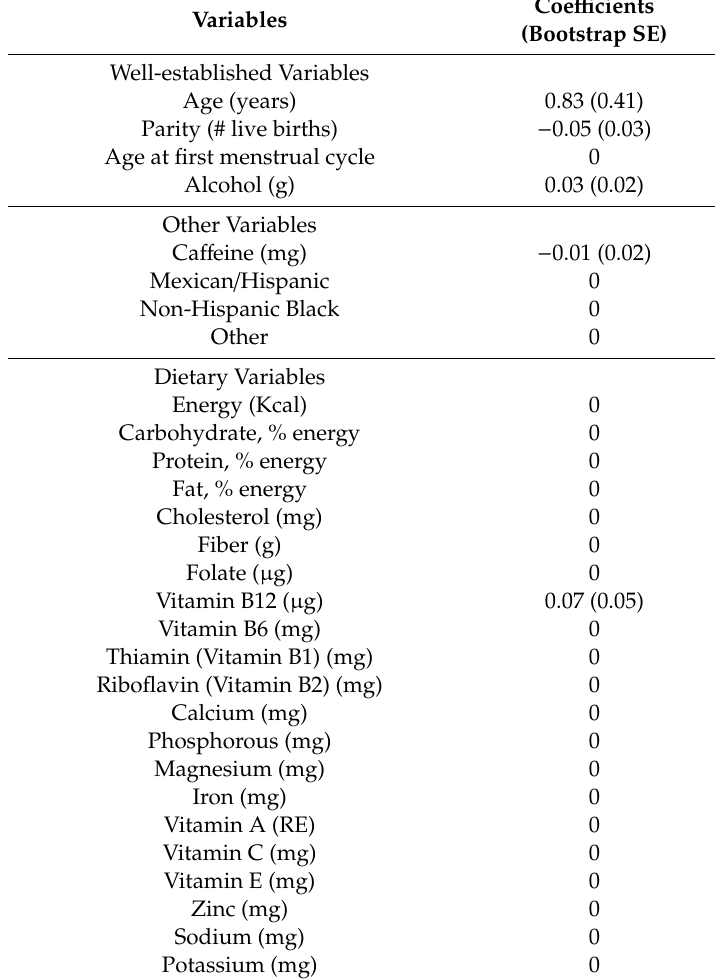
Table 3. The estimated coe ffi cients for logistic least absolute shrinkage and selection operator (LASSO) regression between dietary data, and well-established breast cancer risk factors with self-reported breast